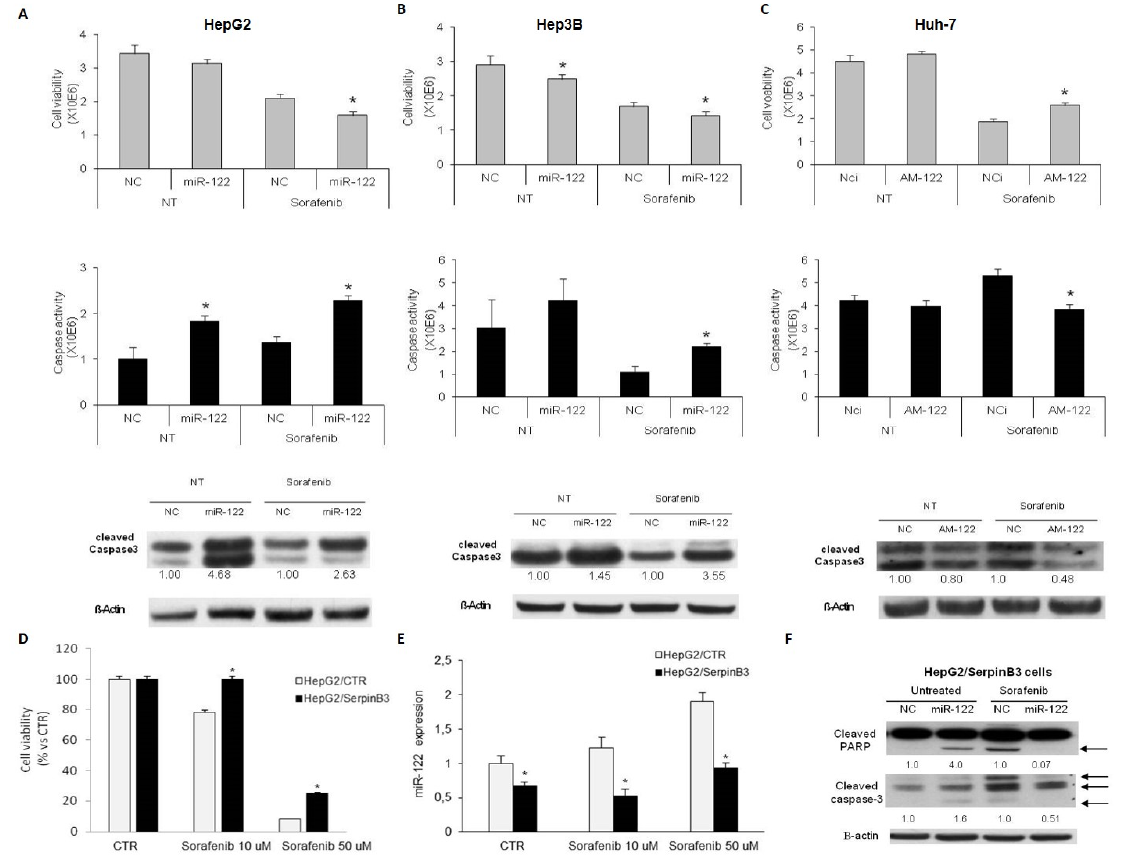
Figure 5. ( A – C ) In each panel, from the top to the bottom: cell viability and caspase 3/7 activity assays and western blot analysis of cleaved caspase-3 in HepG2 and Hep3B cells overexpressing miR-122 ( A , B ) and in Huh-7 cells transfected with miR-122 inhibitor (AM-122) ( C ) following vehicle (NT) or sorafenib administration. β -Actin was used as housekeeping gene in western blot analysis and numbers represent fold-change values. NC: miRNA precursor negative control; NCi: miRNA inhibitor’s negative control. ( D ) Cell viability assay in SerpinB3-overexpressing HepG2 cells following sorafenib treatment (10 and 50 µ M for 48 h). (* p < 0.05 Mann–Whitney test). ( E ) MiR-122 quantification in SerpinB3-overexpressing HepG2 cells following sorafenib treatment. (* p < 0.05 Mann–Whitney test). ( F ) Western blot analysis of cleaved Poly(ADP-ribose) polymerase 1 (PARP) and cleaved caspase-3 in HepG2 cells overexpressing SerpinB3 (HepG2/SerpinB3) transfected with miR-122 in untreated or sorafenib (10 µ M)-treated cells (48 h). β -Actin was used as housekeeping gene in western blot analysis and numbers represent fold-change values. NC: miRNA precursor negative